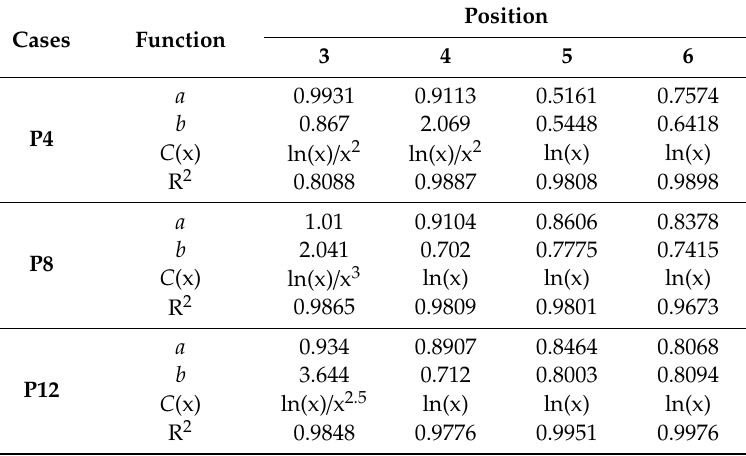
Table 1. Parameters a and b and logarithmic equation C under di ff erent